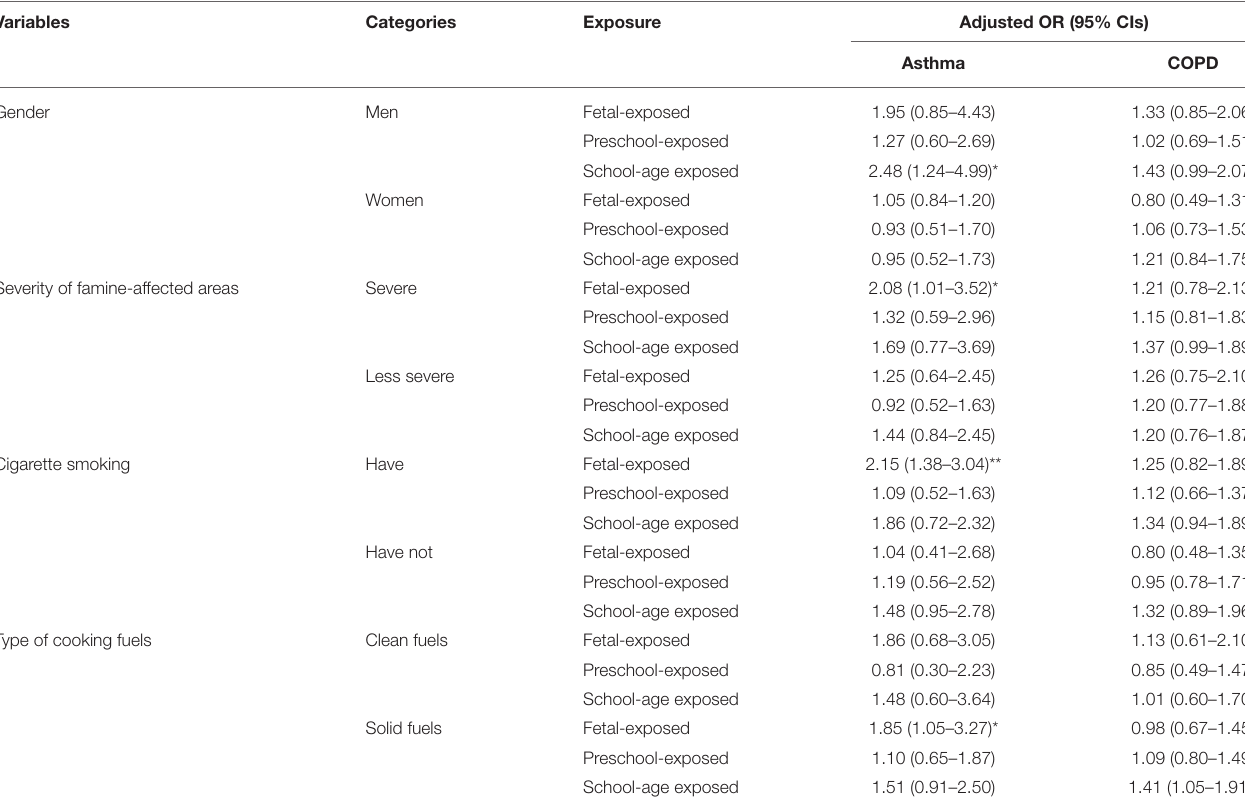
TABLE 4 | Adjusted OR and 95% CI of the association between famine exposure with asthma and COPD stratified by potential modifiers (reference: non-exposed group).